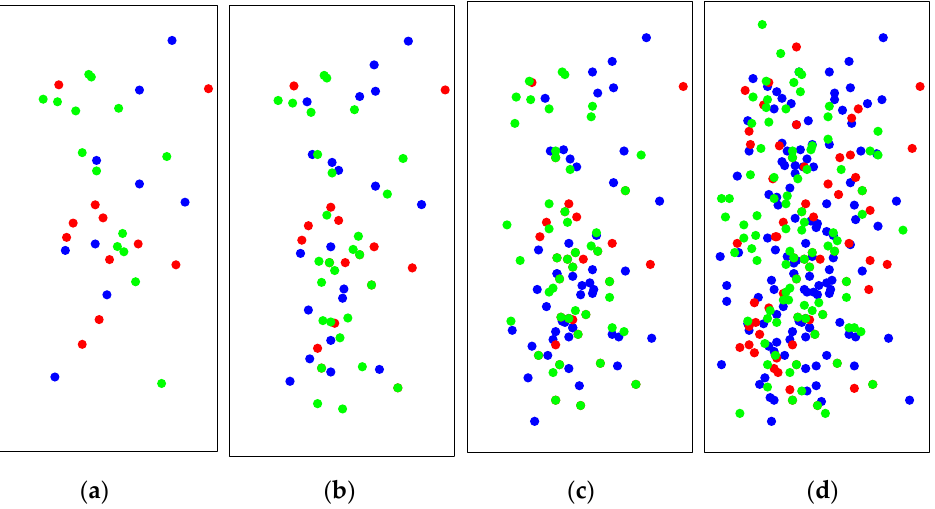
Figure 15. AE spatial location and crack source identification of sample S-T1-0. A blue AE denotes a tensile crack, a red AE denotes a mixed type, and a green AE denotes a shear crack. ( a ) The results when σ cc was reached; ( b ) the results when σ ci was reached; ( c ) the results when σ cd was reached; ( d ) the results when σ p was reached.